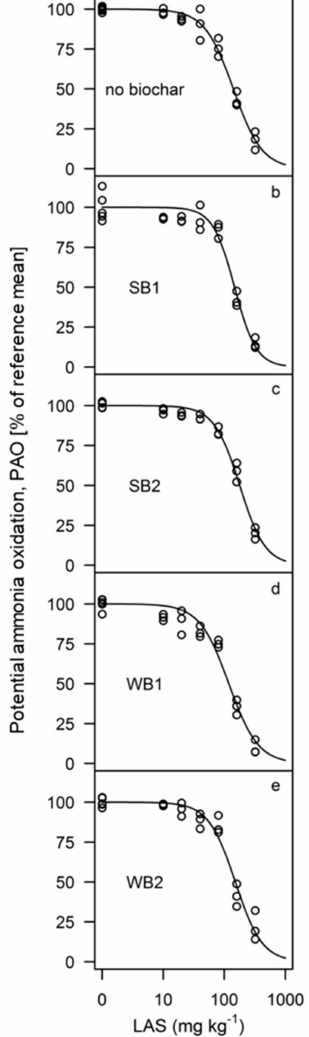
Figure 4. Dose-effects of linear alkylbenzene sulfonate (LAS) on potential ammonia oxidation (PAO) in agricultural soil without ( a ) or with ( b–e ) added biochar (1.1%, wt./wt.). SB1, SB2—straw biochars; WB1, WB2—pine wood biochars. Assays of PAO were performed after 1 week of soil interaction with biochar and